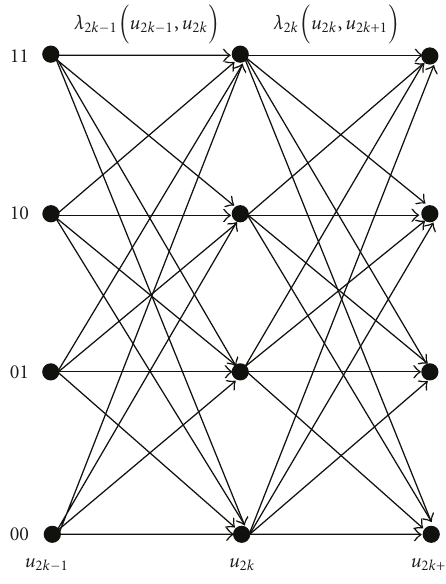
Figure 7: Trellis code for precoded